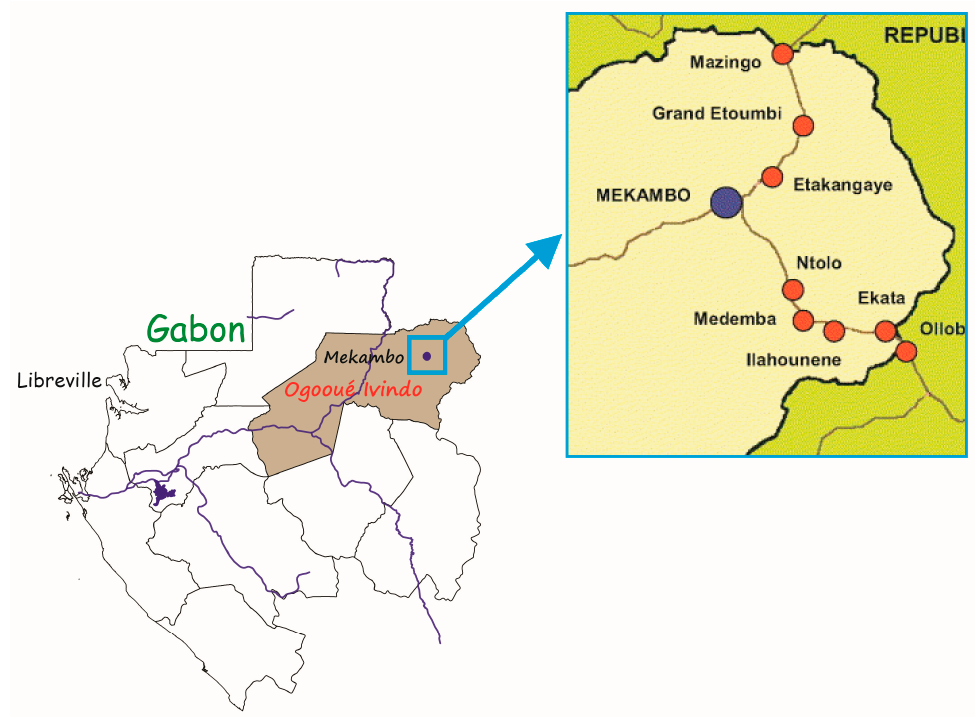
Figure 1. The sampling villages (represented by red dot) of bushmeat in the Zadie department. Table 1. Overall data on the studied